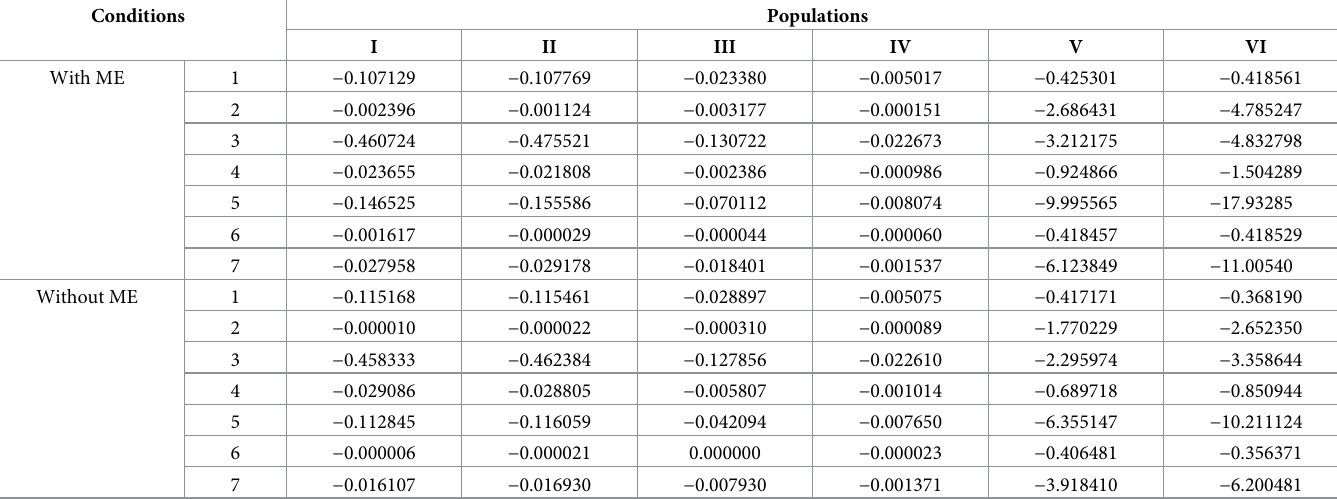
Table 1. Conditional values for the efficiency comparison for population(I-VI).